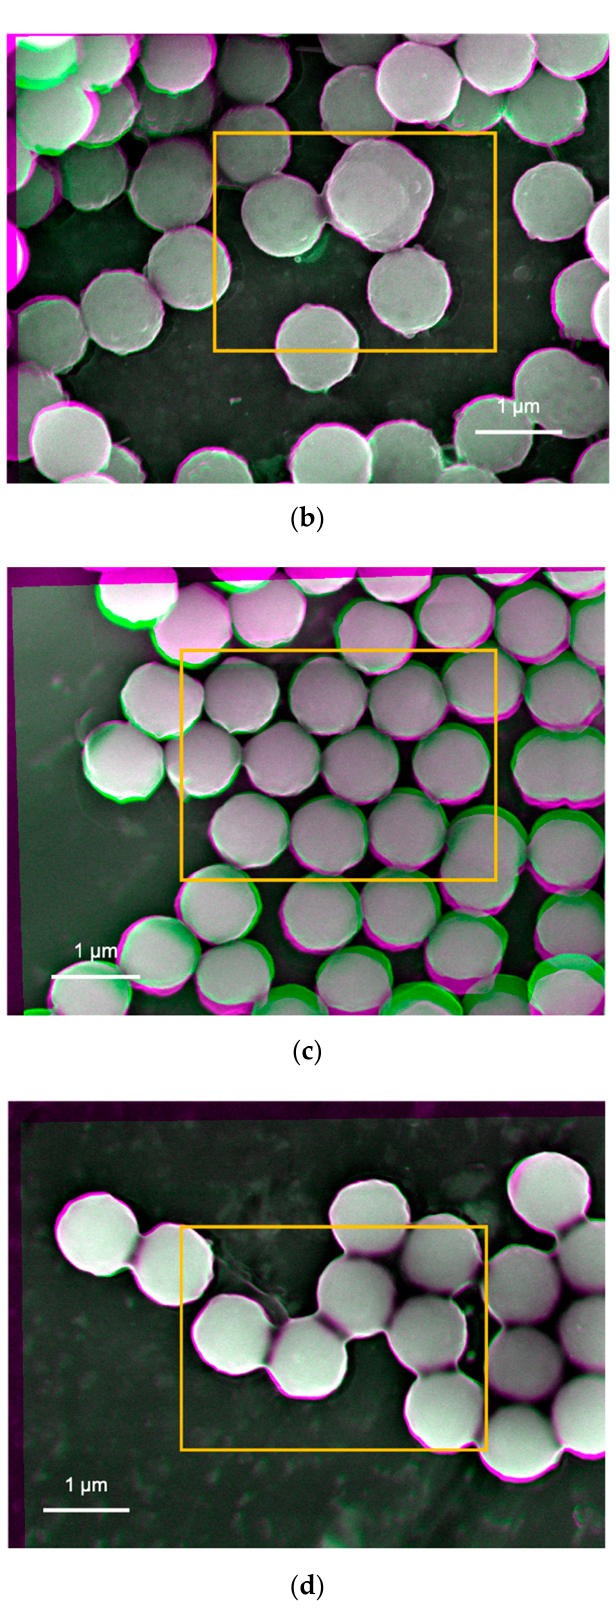
Figure 4. Processed images of the nanoparticle–substrate interfaces after subtracting two images taken at the acceleration voltages of 8.5 and 8.1 keV on the samples of Tug ( a ) 2, ( b ) 3, ( c ) 5, and ( d ) 6.